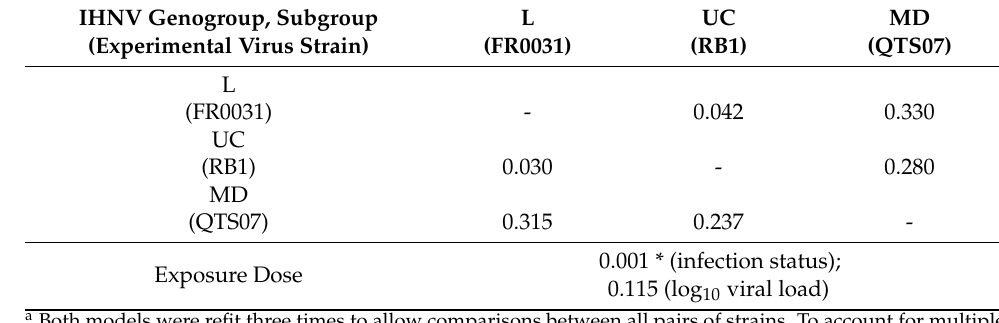
Table 4. p values for regression coefficients examining the relationship between IHNV strains and exposure dose on infection status (below diagonal) and log 10 viral load (above diagonal), assessed using logistic regression and generalized linear models (GLMs), respectively a . IHNV Genogroup, Subgroup L